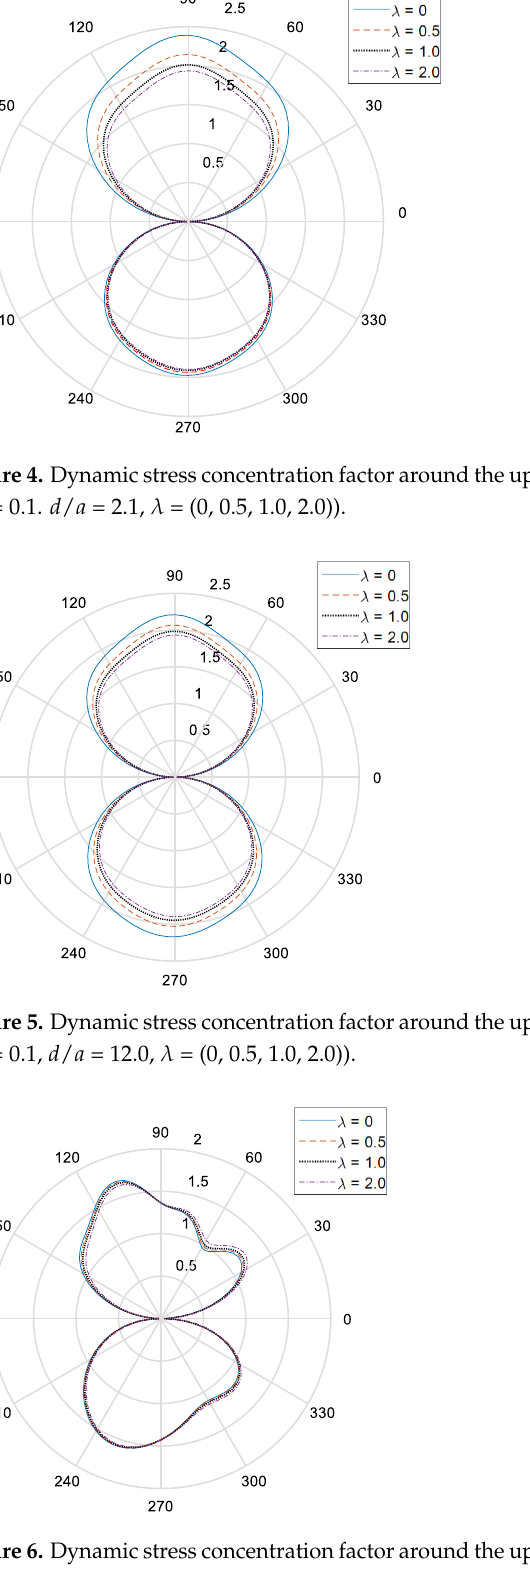
Figure 7. Dynamic stress concentration factor around the upper opening in piezomagnetic compo- sites ( ka  2.0, / d a  12.0,  = (0, 0.5, 1.0, 2.0)). Figure 8 illustrates that a smaller incident wave number causes larger dynamic stress concentrations. When the wave numbers are in the interval of 1.2~1.5 ka  , there are minimum dynamic stress concentrations.